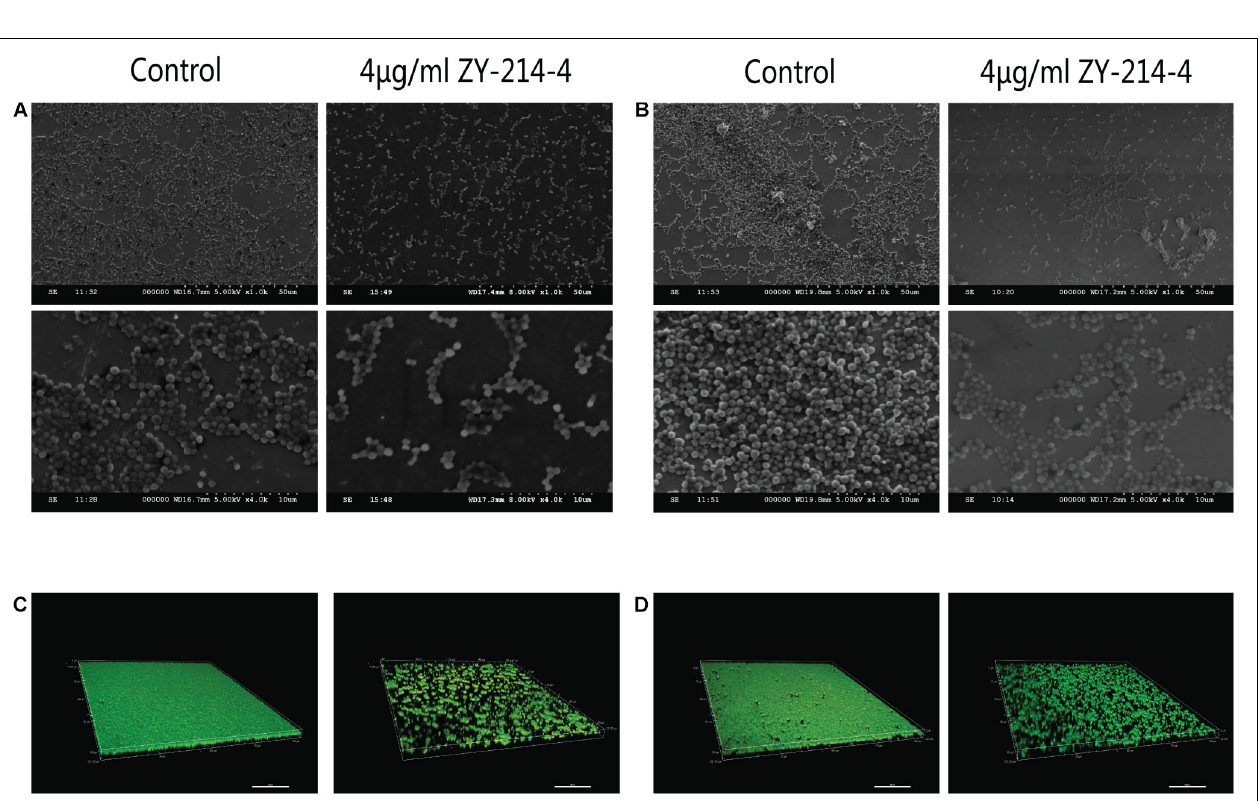
Frontiers in Microbiology |